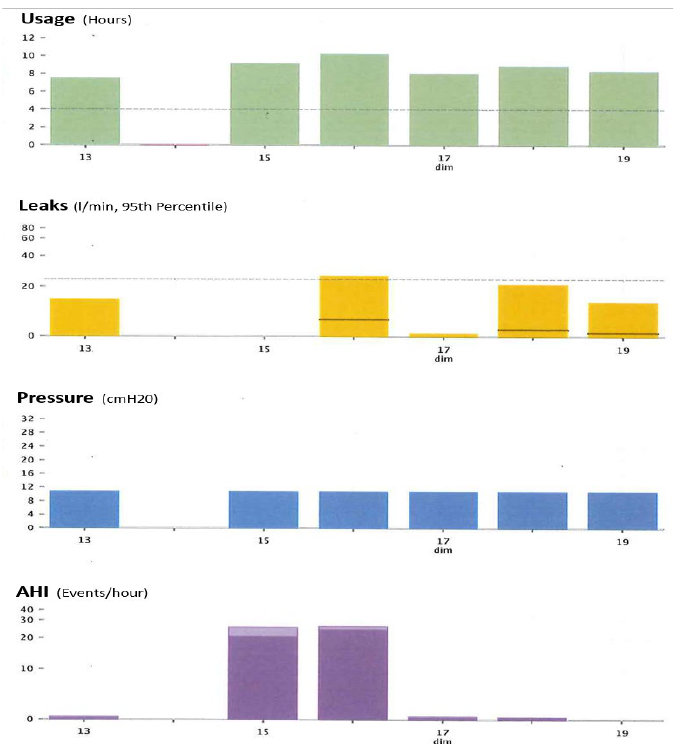
Figure 5. Illustration of the immediate feed-back obtained after mask change. A significant increase in AHI is observed during two nights spent with a naso-buccal mask. Leaks were also significantly increased during the second night. The patient went back to nasal mask use afterwards. AHI: apnea– hypopnea index.